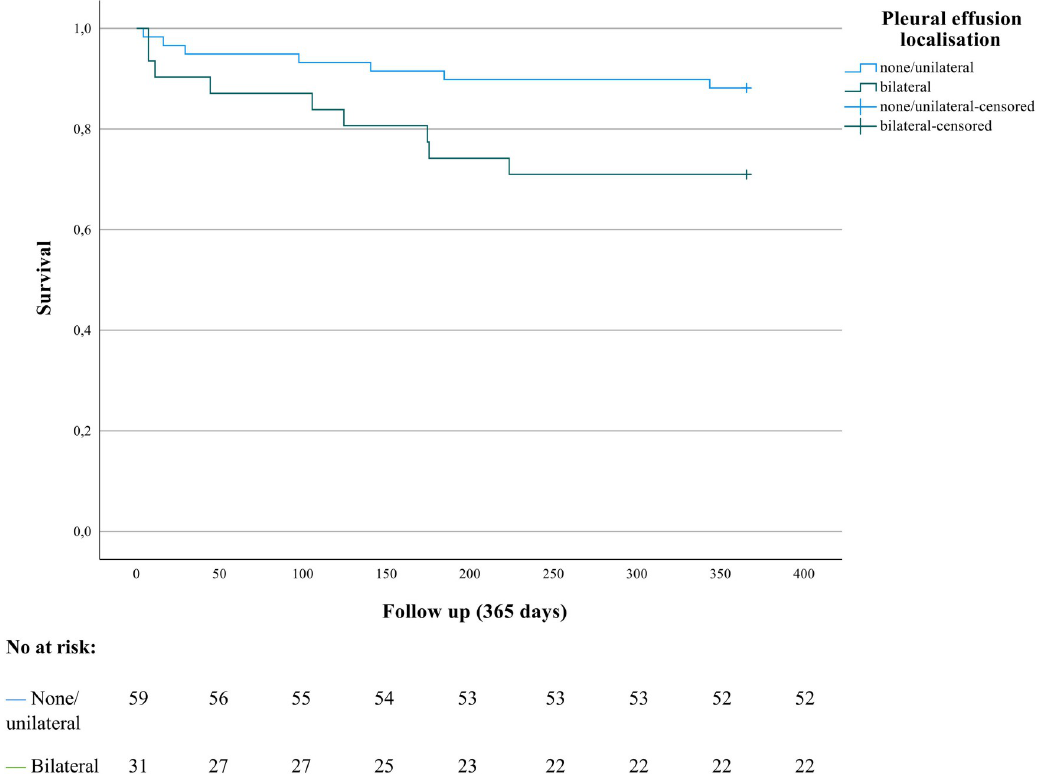
Fig 3. Bilateral pleural effusions in the early phase of acute pancreatitis are associated with worse one-year survival. Kaplan– Meier curves of patients with none or unilateral pleural effusions (PEs) (n = 59) versus patients with bilateral PEs (n = 31) in the early phase (median 2 days after admission) of acute pancreatitis (AP) are shown. Survival data was only available for a subgroup of patients (study centre Halle, Germany, n = 90). Hospitalised patients with AP were followed up for one year after admission. Overall, 16 patients (18%) died during follow up. Of patients with none/ unilateral PEs 12% (7/59) died, whereas 29% (9/31) of the patients with bilateral PEs died. Log rank test showed significant worse one-year survival in the group of patients with bilateral PEs compared to none/ unilateral PEs (p =